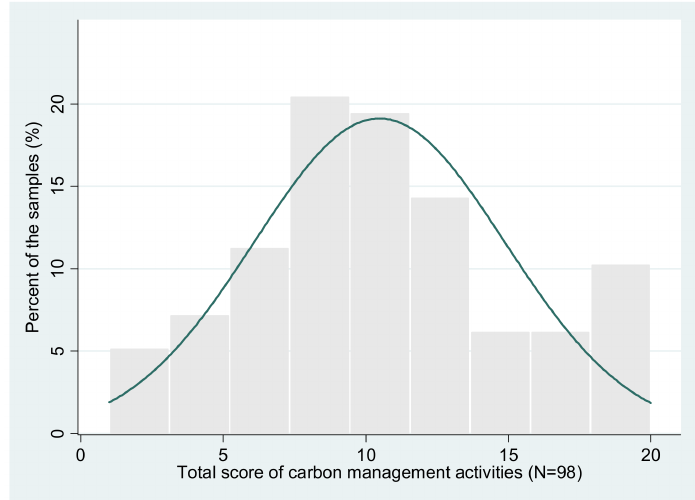
Figure 4. Distribution of overall scores of CMAs ( n =